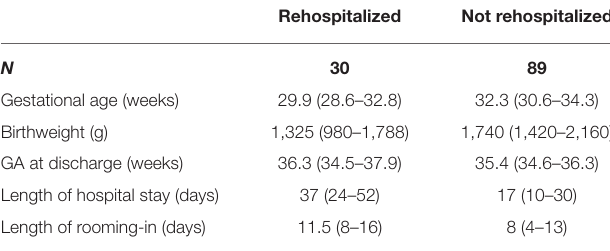
TABLE 4 | Characteristics of rehospitalized and not rehospitalized